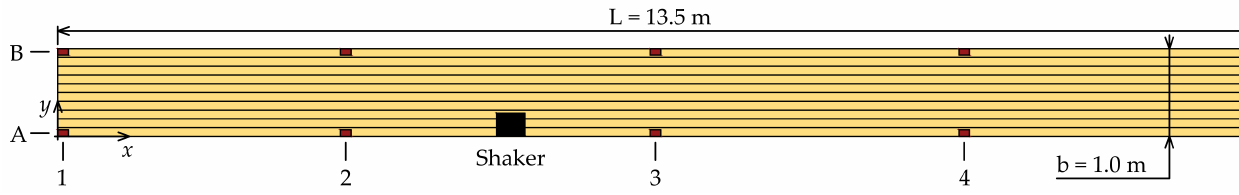
Figure 6. Top view of the measurement layout for the validation